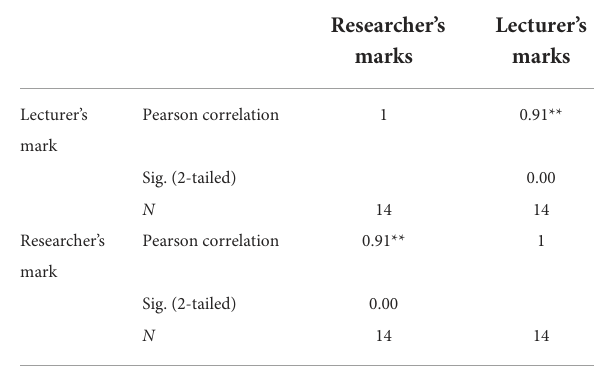
TABLE 1 In-class writing task 1.